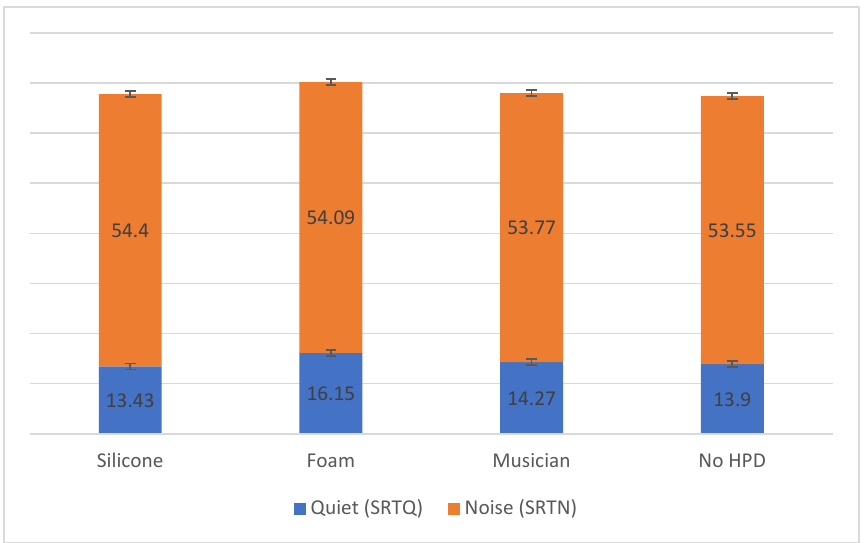
Figure 3. Sentence recognition thresholds in quiet and noise with and without HPD. Legend—SRTQ: sentence recognition threshold in quiet (dBSL); SRTN: sentence recognition threshold in noise (dBSL).